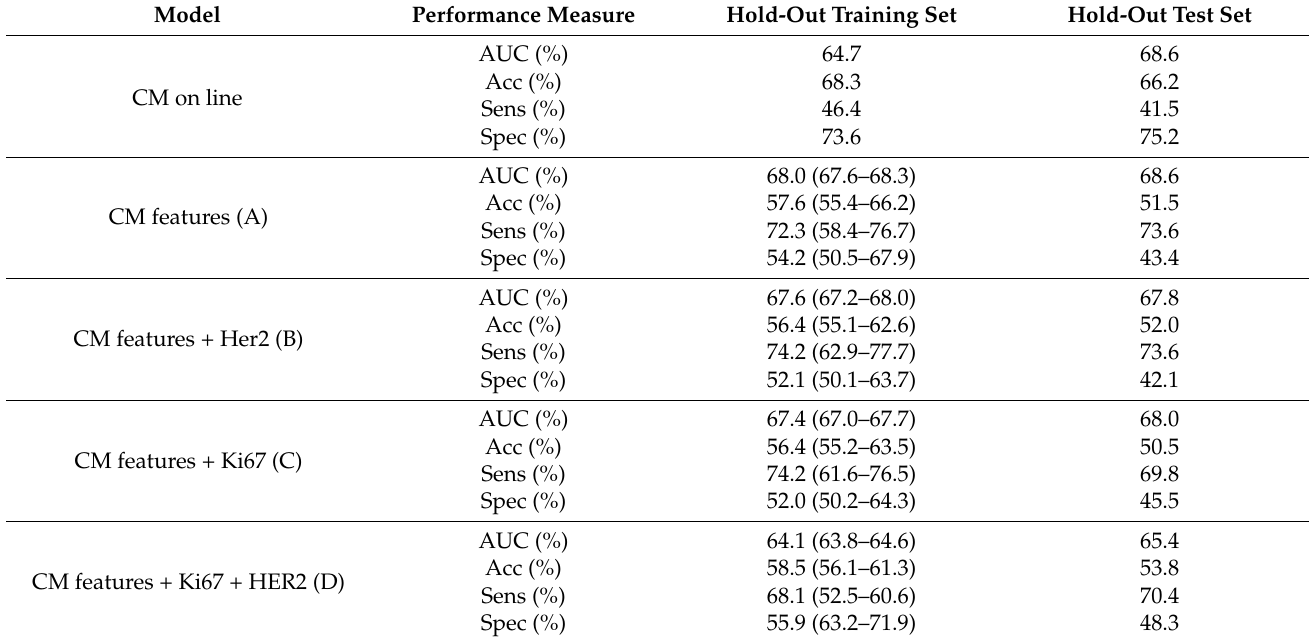
Table 2. Classification performances obtained by online CancerMath (CM) application and by training A, B, C, and D models on our dataset. The prediction performance of A, B, C, and D models obtained on the hold-out training set were evaluated on 100 ten-fold cross-validation rounds and summarized in terms of median, 1st, and 3rd